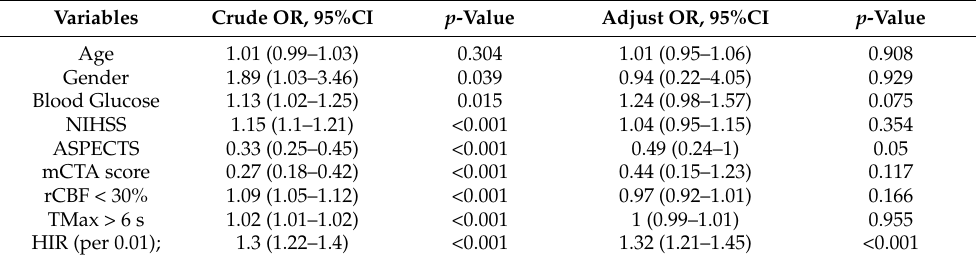
Crude model: no other covariates were adjusted. Adjusted model: we adjusted age, gender, blood glucose, NIHSS, ASPECTS, mCTA score, rCBF < 30%, TMax > 6 s. Abbreviations: NIHSS, National Institutes of Health Stroke Scale; ASPECTS, Alberta Stroke Program Early Computed Tomography Score; mCTA, multiphase CTA; rCBF, relative cerebral blood flow; TMax, the time when the residue function reaches its maximum; HIR, hypoperfusion intensity